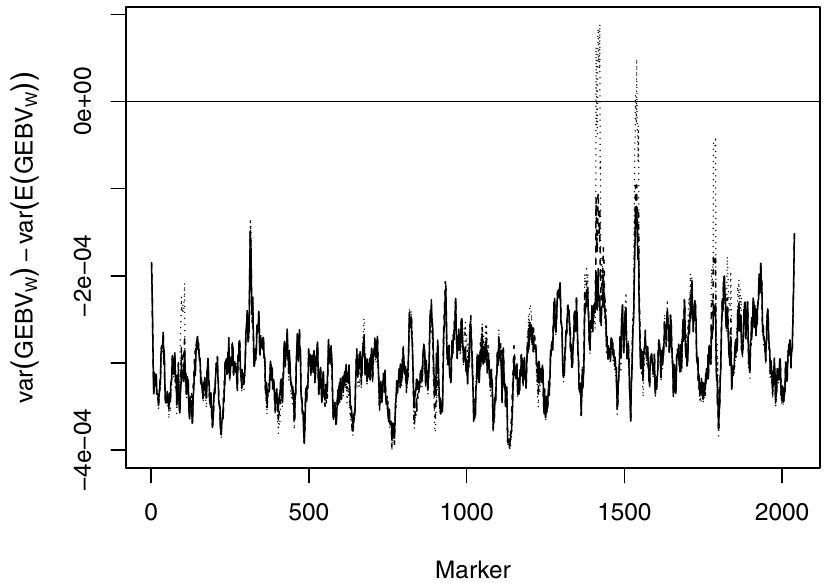
Figure 4. Comparison of GWAS results generated with SNP-BLUP (solid line), BayesA (dashed line) and BayesC (dotted line) on BTA 6 in a sample of the German Holstein population. For each window, the deviation of the variance of the estimated genomic breeding value from its expected value is shown. The horizontal solid line corresponds to a deviation of